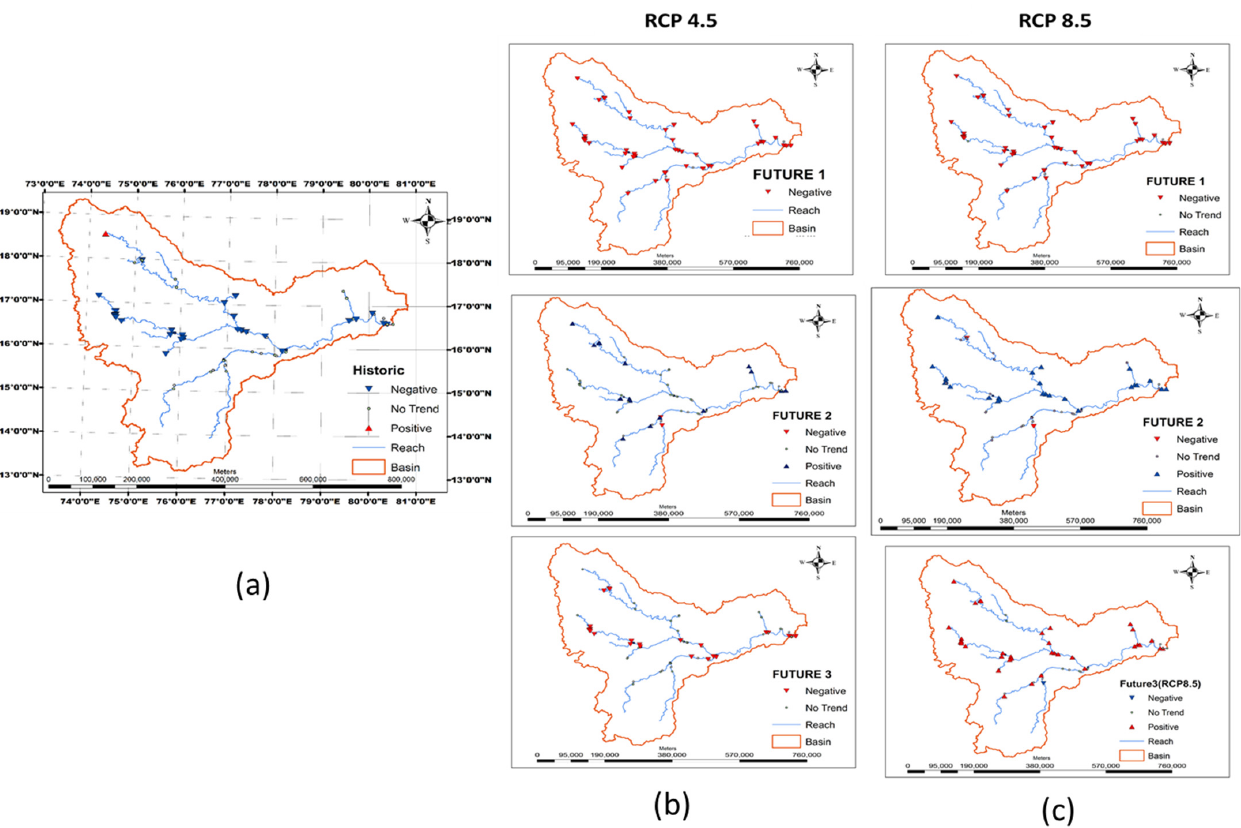
Figure 12. Annual streamflow trends ( a ) historic, ( b ) RCP 4.5 scenario, ( c ) RCP 8.5